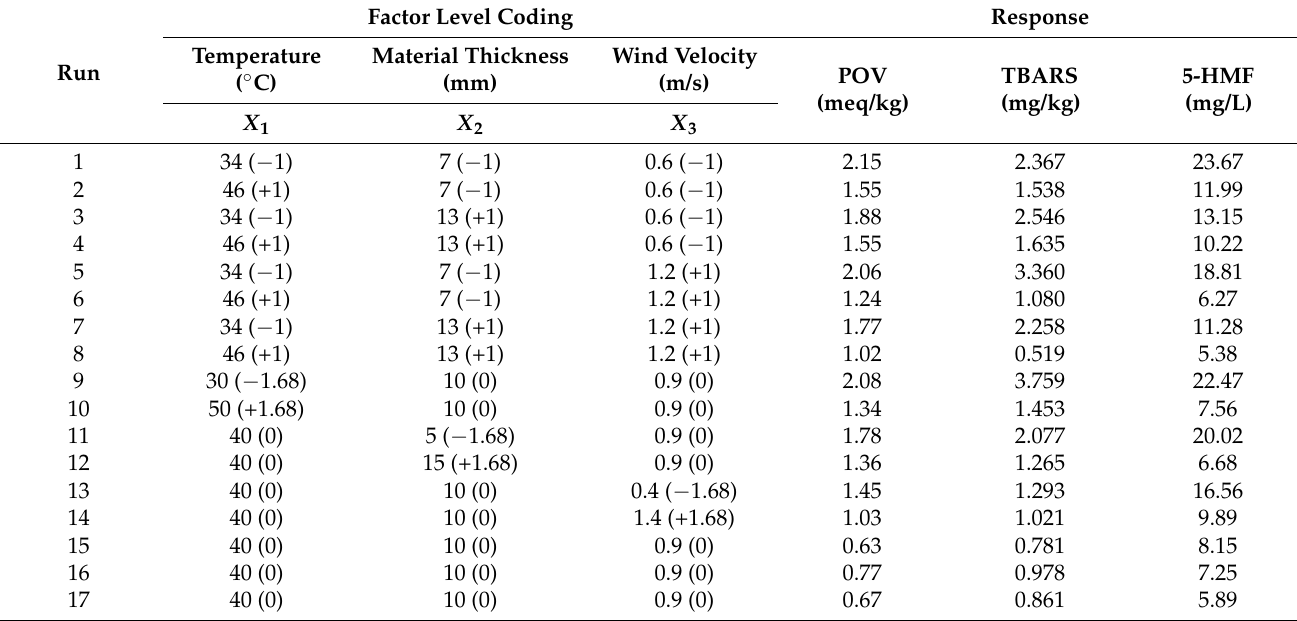
Table 2. The CCD matrix and the experimental data for the